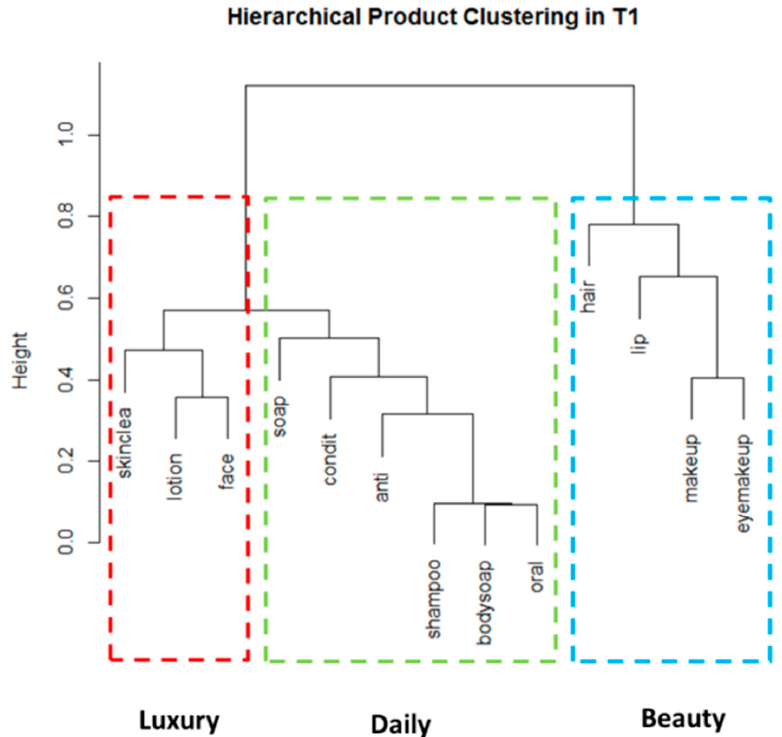
Figure 8. Dendrogram representing hierarchical clustering from T1. (Three clusters of PCPs that are commonly used together are identified: Cluster 1 (Luxury)—”skinclea”, “lotion” and “face”; Cluster 2 (Daily)—”soap”, “condit”, “anti”, “shampoo”, “bodysoap”, “oral”); Cluster 3 (Beauty)—”hair”, “lip”, “makeup”, “eyemakeup”. PCPs with a height closer to zero are more closely related; PCPs with a height closer to 1 are not related.).